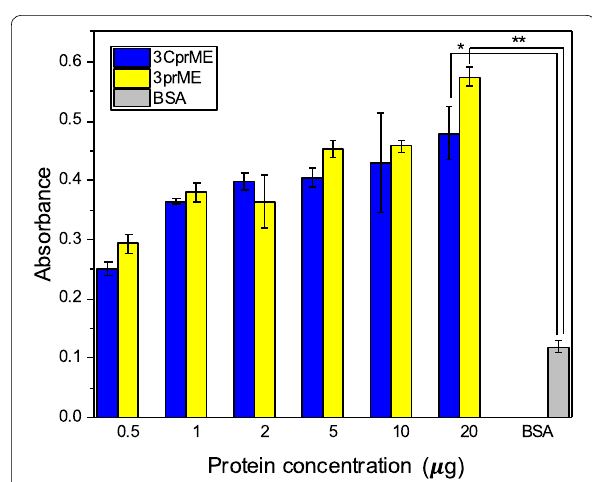
Fig. 5 Binding assay of DENV-LPs/3CprME and /3prME to heparin using ELISA. Heparin (1.8 ng) was coated onto each well of a microplate and the ELISA protocol was carried out according to “Materials and methods”